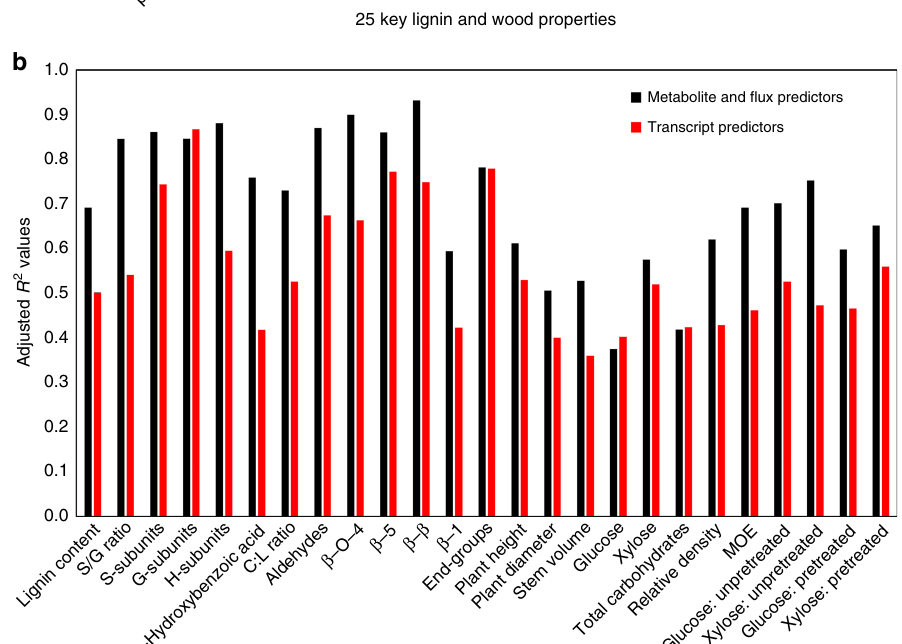
C:L ratio (Fig. 10b). Downregulation of PAL , C3H and CCoAOMT gene families is predicted to yield the best overall wood quality (Fig. 10c), with ~41% increase in wood density, ~153 and ~456% increase in glucose and xylose release, respectively, and ~140% increase in the C:L ratio (Fig. 10c).